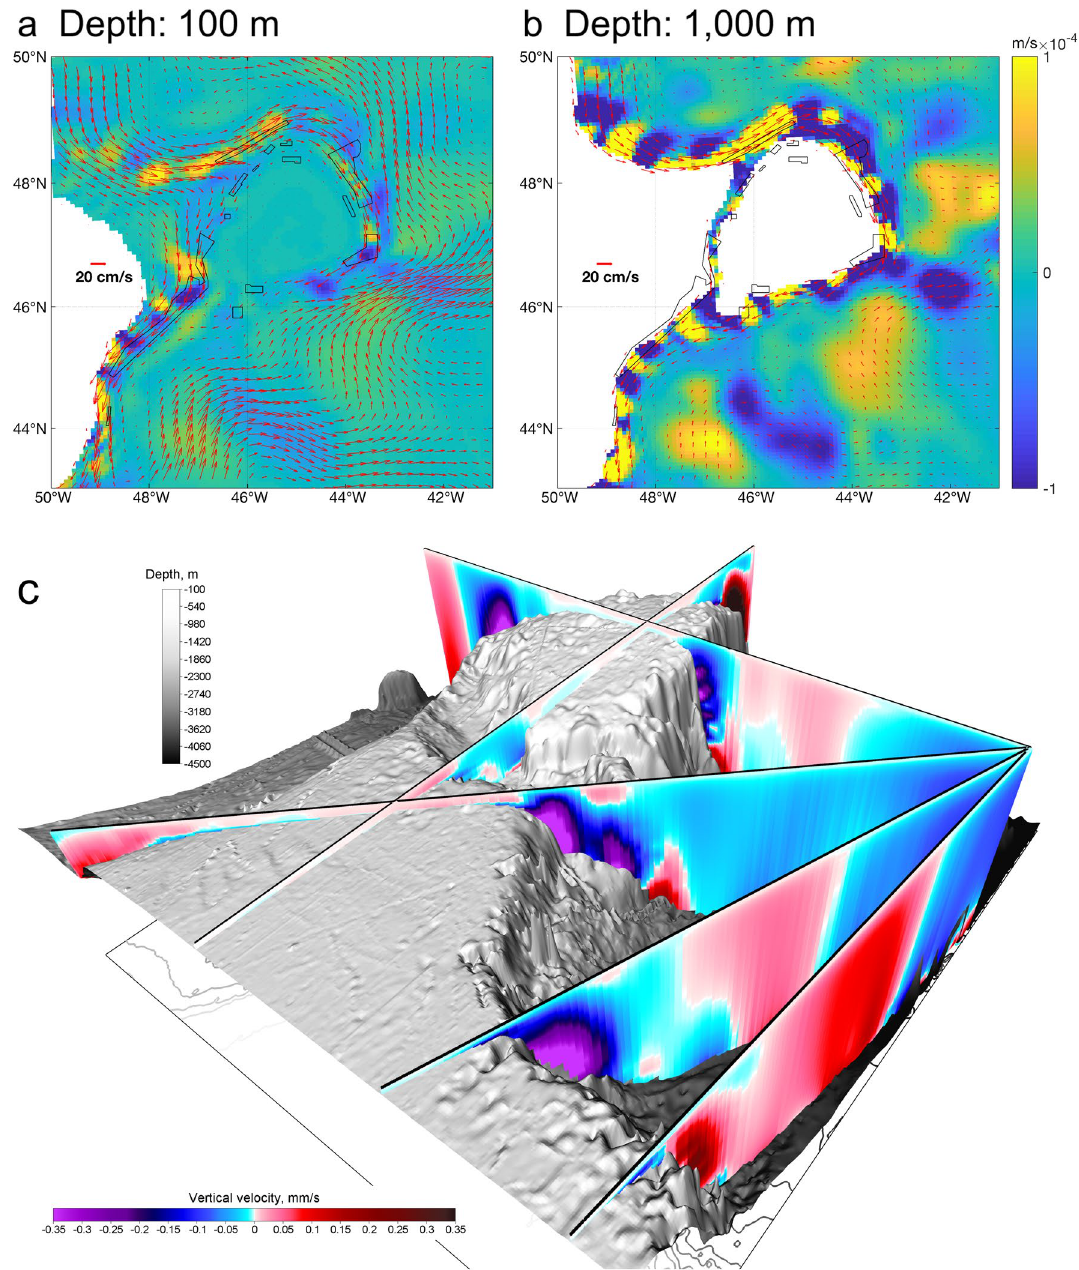
Figure 8. Distributions of horizontal velocity vectors (cm/s) and vertical velocity contours (m/s × 10 –4 ). ( a ) 100 m and ( b ) 1000 m depth in the Flemish Cap area of the northwest Atlantic. Positive (yellow) and negative (blue) values denote upward and downward velocity respectively. ( c ) Vertical velocity slices showing areas of upward (reds) and downward (purples) velocity. The areas closed by NAFO to protect deep-sea sponges, corals and sea pens are outlined in black in ( a , b ). All data were derived from the BNAM oceanographic model. The maps in ( a , b ) were generated using bathymetry and coastline data produced and made publically available by the NOAA National Centers for Environmental Information (NCEI). The ETOPO1 Ice Surface (https:// doi. org/ 10. 7289/ V5C82 76M) arc-minute global relief model of the Earth’s surface (https:// www. ngdc. noaa. gov/ mgg/ global/) was used to generate bathymetry and the Global Self-consistent, Hierarchical, High-resolution Geography Database (GSHHG; https:// www. ngdc. noaa. gov/ mgg/ shore lines/ gshhs. html) was used to produce co-ordinates for a high-resolution coastline and both plotted using Matlab version 9.5 software (https:// www. mathw orks. com ) with the M_Map mapping package (version 1.4 m, created by R. Pawlowicz, https:// www. eoas. ubc. ca/ ~rich/ map. html). The 3-D map in 8c was generated using the ETOPO1 Ice Surface bathymetry and plotted with Voxler software (https:// www. golde nsoft ware. com/ produ cts/